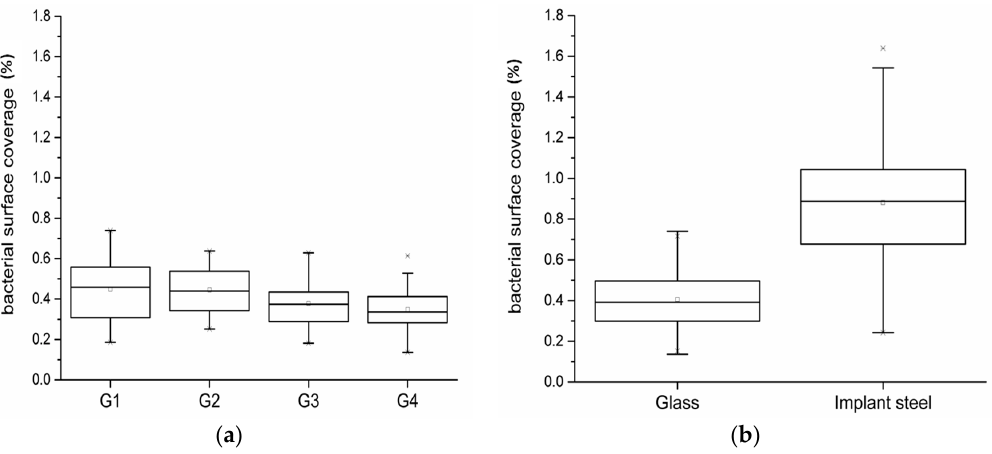
Figure 5. Box-Whisker plot for the results of ( a ) the four experiments with glass (each box includes the bacterial coverage data (%) of up to 32 material coupons, for a total of 107); and ( b ) for the experiments with glass (G1–G4) and implant steel (63 coupons, results shown in detail in Figure 4).